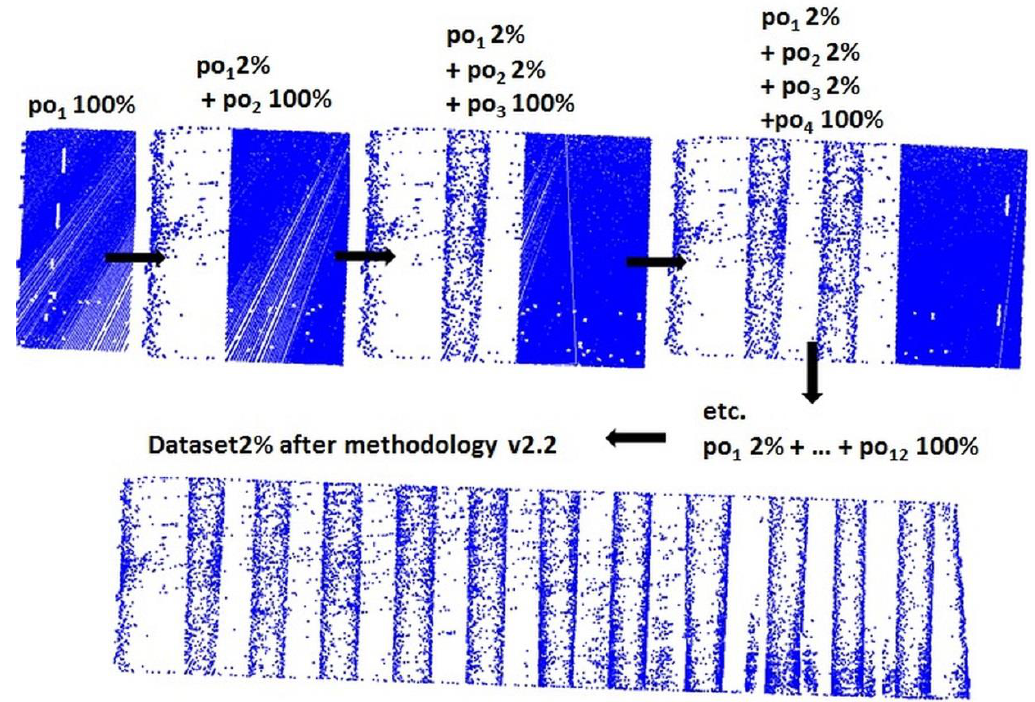
Figure 7. Scheme of test area division into strips with overlay (methodology v2.2).